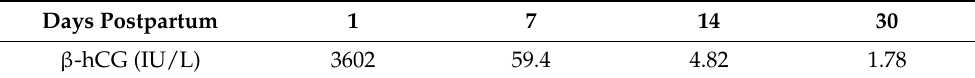
Table 1. Patient’s β human chorionic gonadotropin ( β -hCG) levels postpartum. Days Postpartum